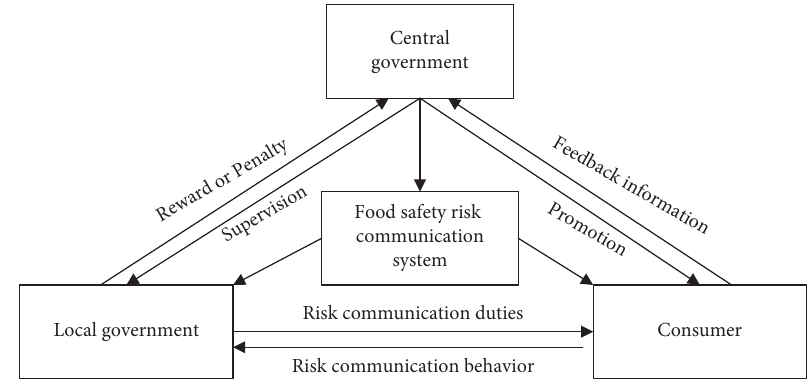
Figure 2: System model between regulators and